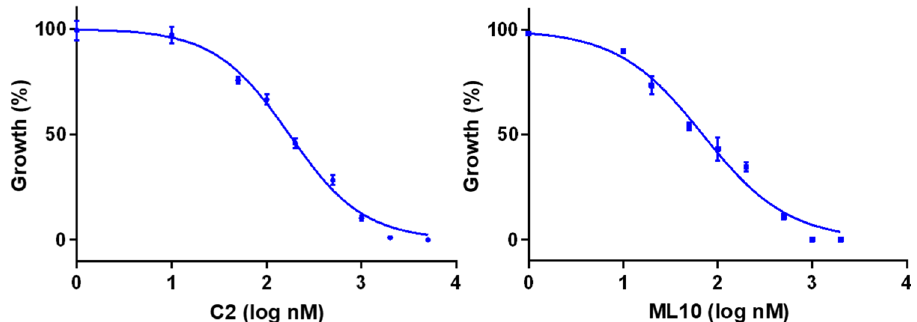
Figure 2. Dose–response curve of C2 and ML10 for B. bovis . The parasites were cultured in presence of different concentrations of C2 or ML10. Data are shown as mean ± SEM of triplicate culture.